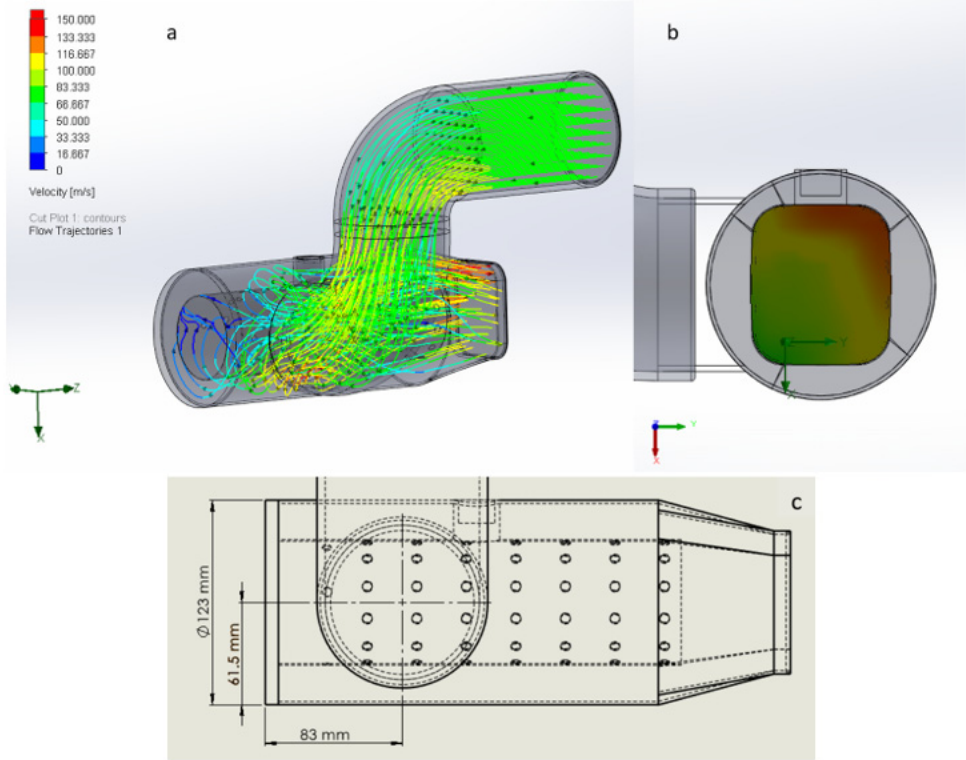
Figure 6. ( a ) CFD simulation of the original Giandomenico design. ( b ) Velocity distribution of the outflow. ( c ) Technical detail of the middle-middle position for air pipe. The original approved design shows an improvement in the CFD simulation. Inside the holed pipe, the flow has a robust swirl. At the turbine inlet, the velocity pattern is quite regular even if the upper red vectors indicate that the velocity is not perfectly uniform (Figure 6b), and an undesired moderate tumble is present at the turbine intake. It is prob- pipe has a direct influence on the combustion efficiency. Therefore, the geometry is mod- ified to improve the swirl inside the holed pipe. In the first design solution of Figure 7, the offset from the duct of the compressor is displaced by increasing the offset from the holed pipe axis. The technical details of this position for the air pipe are given in Figure 7c. In